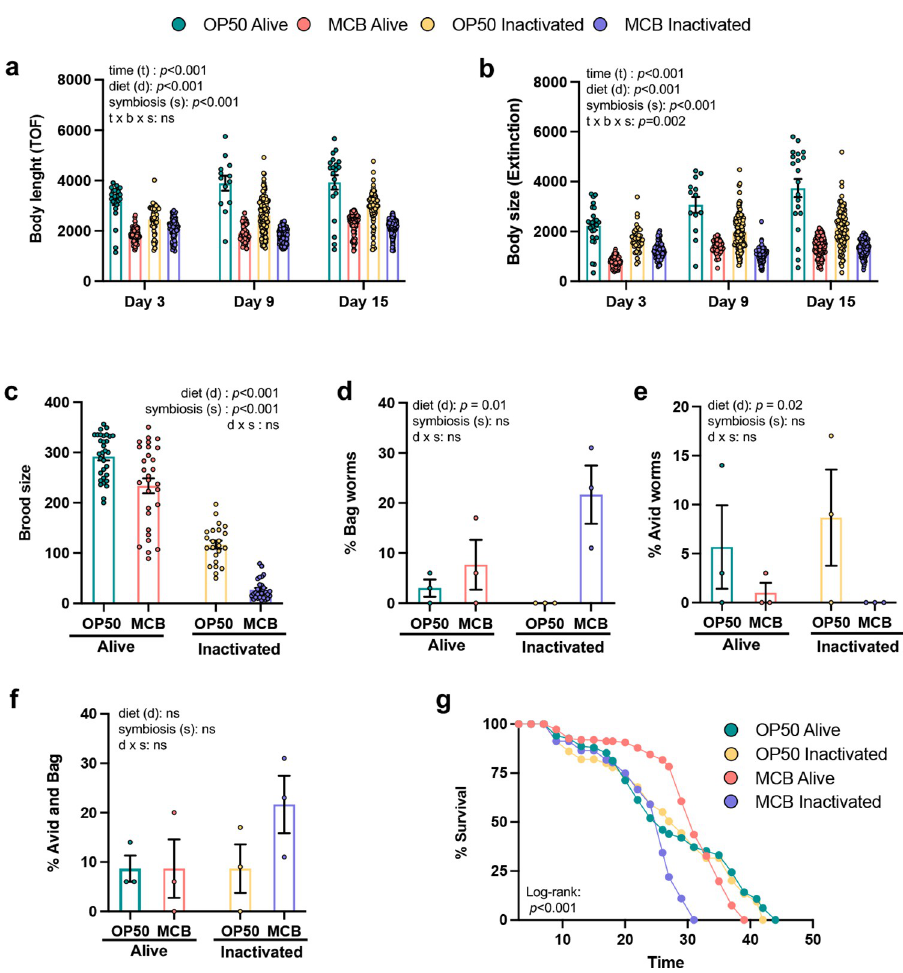
Fig 4. Comparative effects of MCB on reproduction and healthspan of C . elegans . ( a) Body length based on relative axial length (Time of flight, TOF) of worms fed E . coli OP50 versus MCB either alive or inactivated for the indicated time points. Each point represents an individual worm. (b) Body size of worms fed E . coli OP50 versus MCB either alive or inactivated. Each point represents an individual worm. ( c) Brood size of worms fed E . coli OP50 versus MCB either alive or inactivated. 30 worms were tested individually per group. (d) Percentage of worms showing a Bag phenotype over the reproductive period in worms fed with E . coli OP50 or MCB either alive or inactivated. Data represent the mean ± SEM values on 35 worms/replicate for a total of 105 worms. (e) Percentage of worms showing an Avid phenotype over the reproductive period in worms fed with E . coli OP50 or MCB either alive or inactivated. Data represent the mean ± SEM values on 35 worms/replicate for a total of 105 worms. Statistical comparisons by 2 x 2 ANOVA. ns, no significant. ( g) Survival curves of worms fed on E . coli OP50 versus MCB either alive or inactivated. n = 150 per group, see also S4 Table in S1